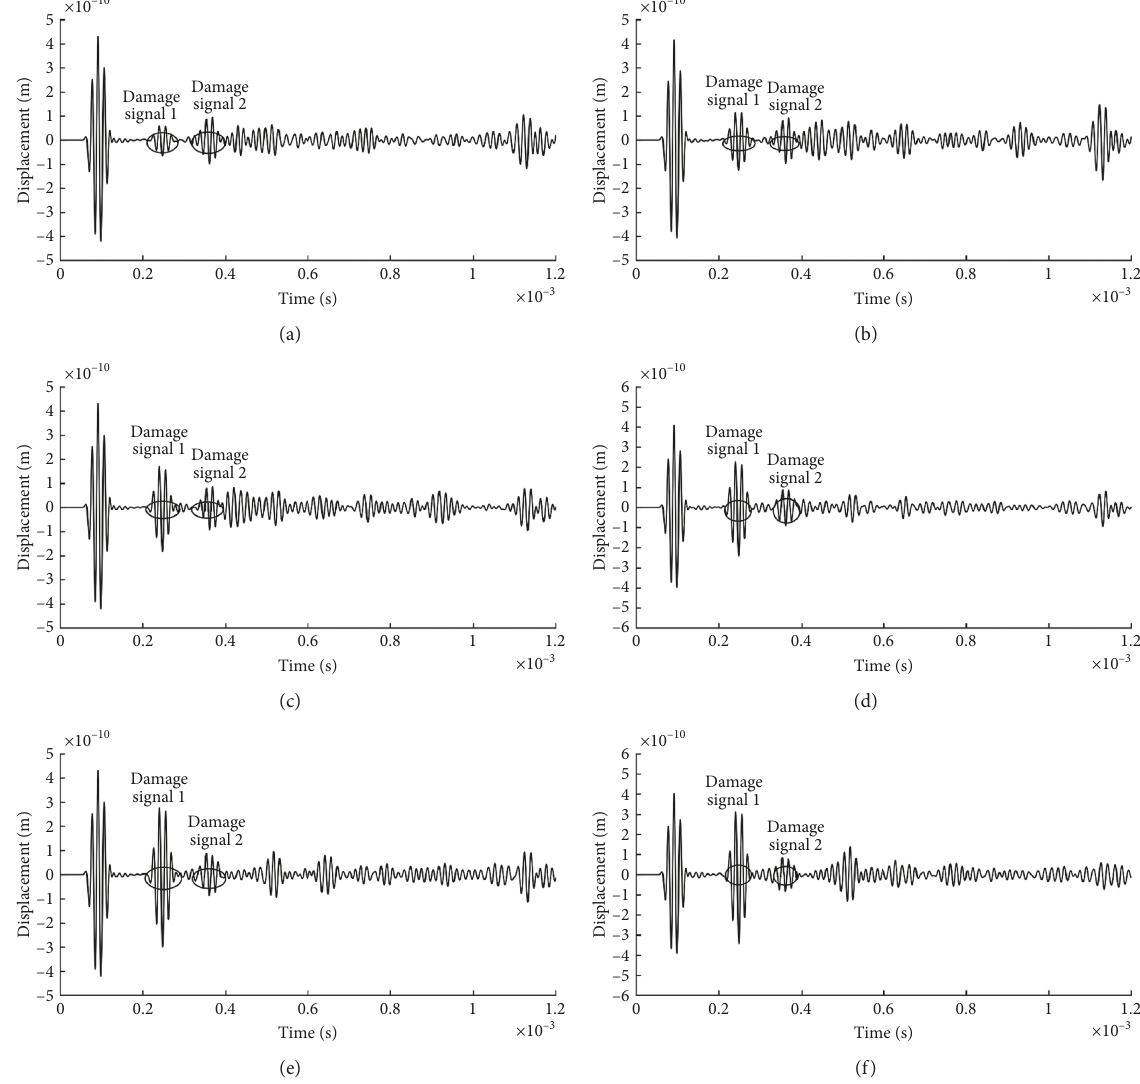
Figure 13: Time domain diagram of guided waves with different defect sizes. (a) Circumferential angle is 15 ° . (b) Circumferential angle is 30 ° . (c) Circumferential angle is 45 ° . (d) Circumferential angle is 60 ° . (e) Circumferential angle is 75 ° . (f) Circumferential angle is 90 °